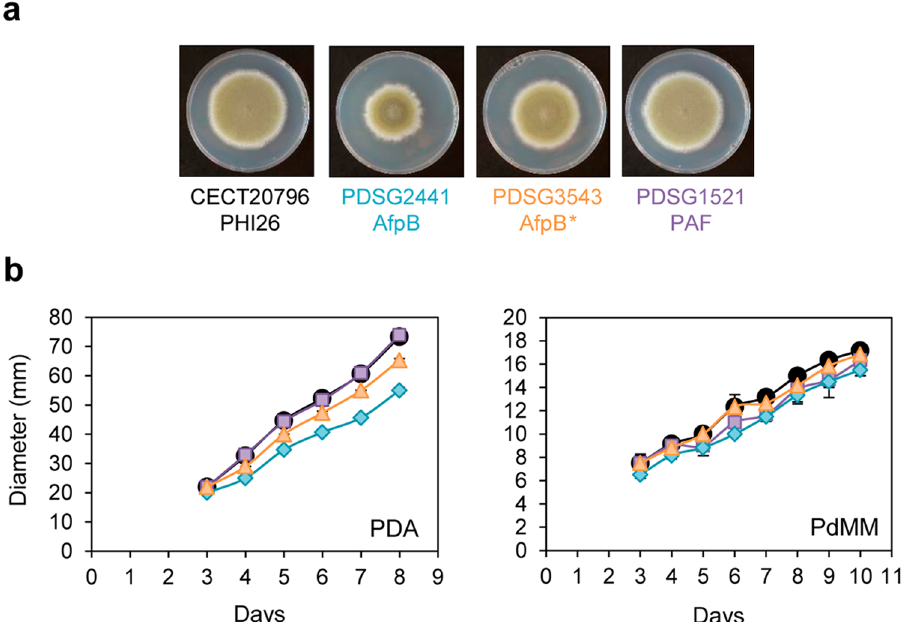
Figure 2. Growth of P . digitatum AfpB, AfpB * and PAF producer strains. ( a ) Colony morphology after 7 days of growth in PDA plates. ( b ) Growth on solid PDA and PdMM determined by the colony diameter from 3 to 10 days of growth at 25 °C. Plotted data are mean values ± s.d. of triplicate samples. The strains